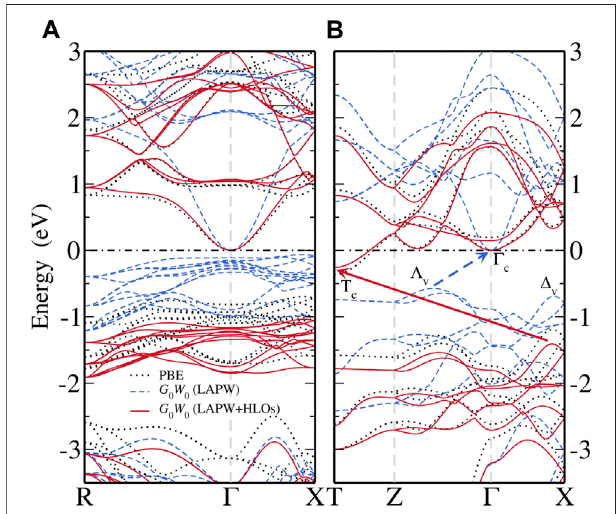
FIGURE 3 | Comparison of band structures computed from PBE (black dotted), G 0 W 0 @PBE with the standard LAPW basis (blue dashed) and G 0 W 0 @PBE with the LAPW basis extended by optimized HLOs (LAPW + HLOs, red solid) for (A) pyrite and (B) marcasite FeS 2 . The conduction band minimum is aligned as the energy zero and marked by the black dash-dotted